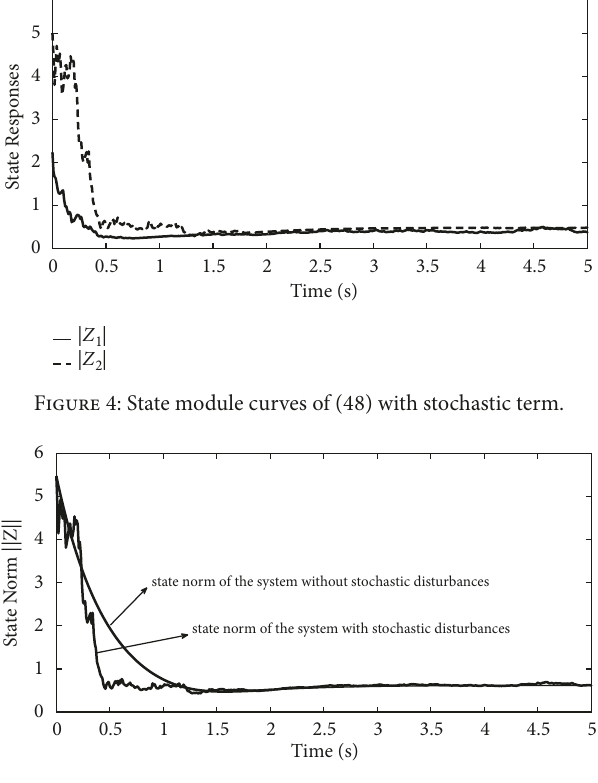
Figure 5: State norm curves of (48) with/without stochastic